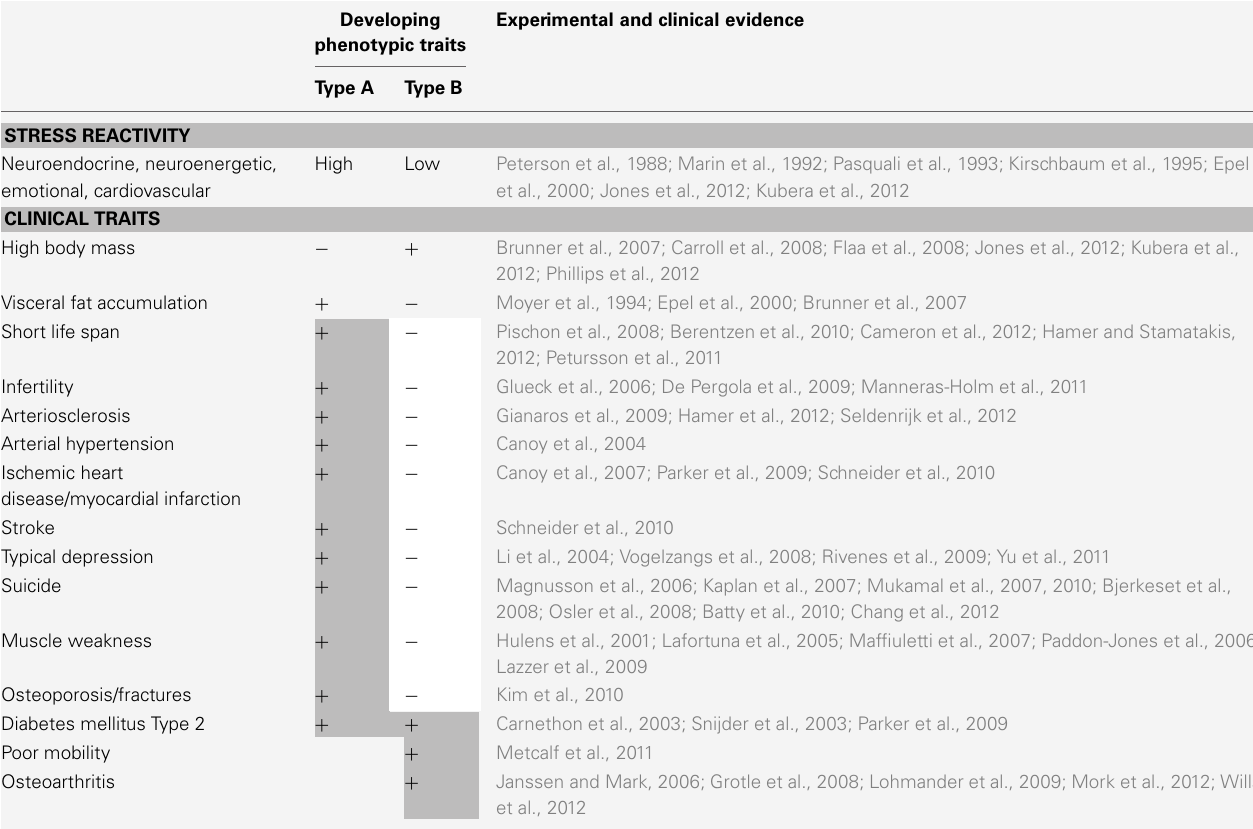
Table 2 | Distinct phenotypic traits developing in stressful